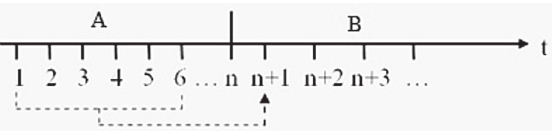
Fig. 1. Graphical illustration of problem statement